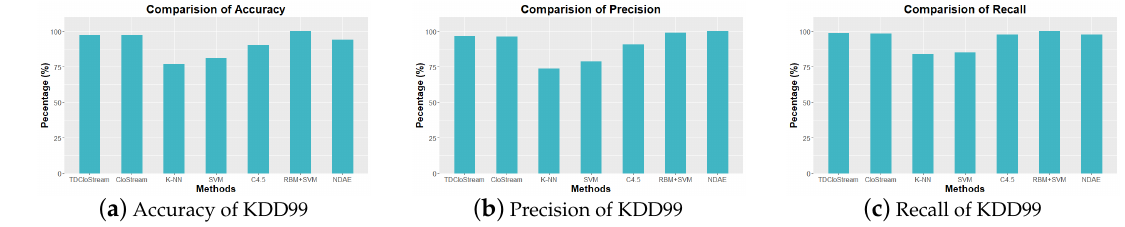
Figure 5. Accuracy, precision and recall of the KDD99 dataset.